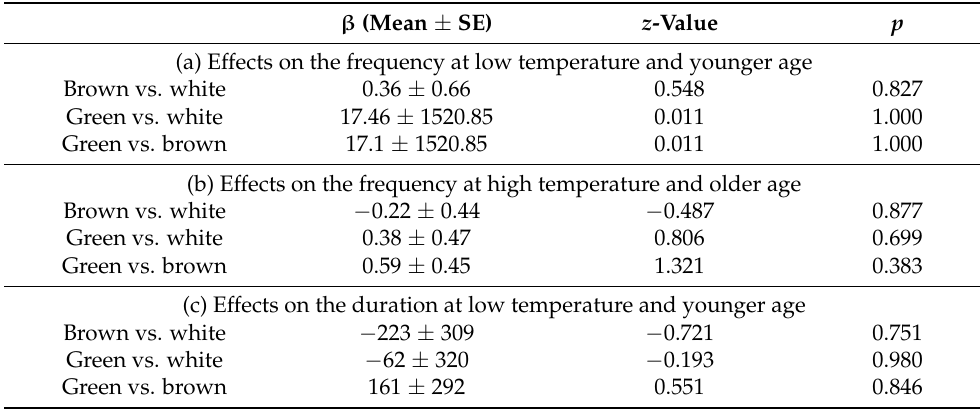
Table 3. Pairwise comparisons of generalized linear models of the effects of background color on the frequency and duration of thanatosis in H. prosopidis females. β (Mean ± SE) z -Value p (a) Effects on the frequency at low temperature and younger age Brown vs. white Green vs. white Green vs. brown Brown vs. white Green vs. white (c) Effects on the duration at low temperature and younger age Brown vs. white − 223 ± 309 Green vs. white Green vs.